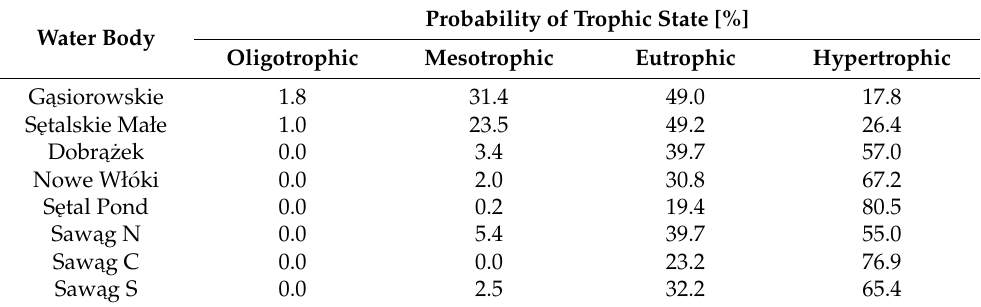
Table 3. Trophic status of analysed water bodies based on concentrations of phosphorus and chloro- phyll, and Secchi depth, expressed as probability of a given trophic class, based on the method described by Vollenweider and Kerekes